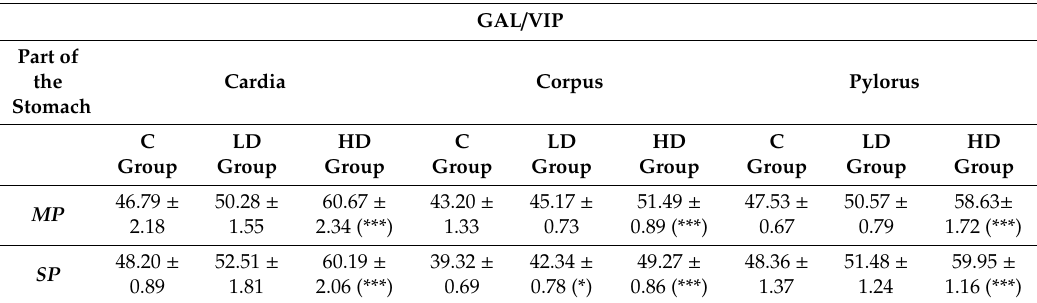
Table 2. Co-localization of GAL with vasoactive intestinal polypeptide (VIP) in the enteric neurons in various parts of the porcine stomach under physiological conditions (C group) and after low dose (LD group) or high dose (HD group) of acrylamide administration.